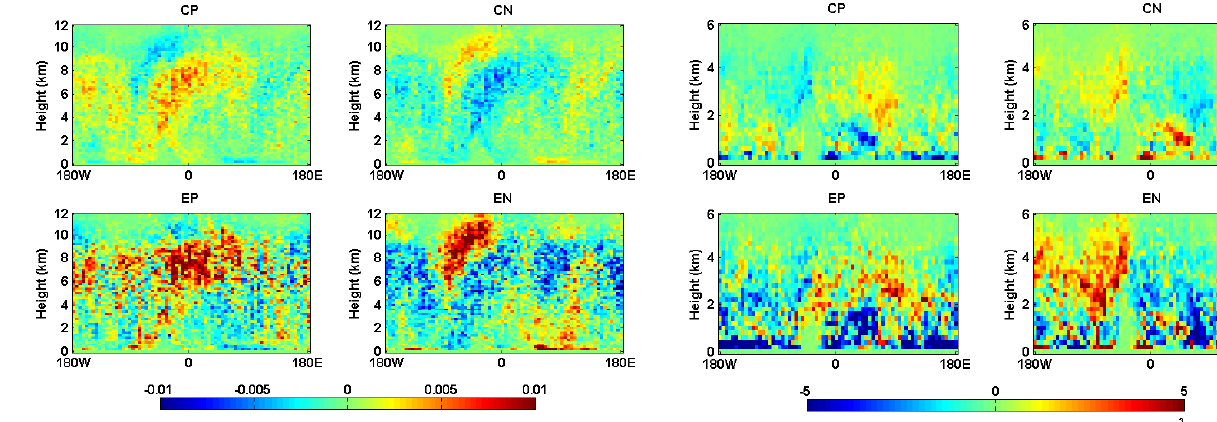
Fig. 7: Same as Fig. 5, but only for liquid phase clouds derived using CALIPSO data. Fig. 7. Same as Fig. 5, but only for liquid phase clouds derived using CALIPSO data.